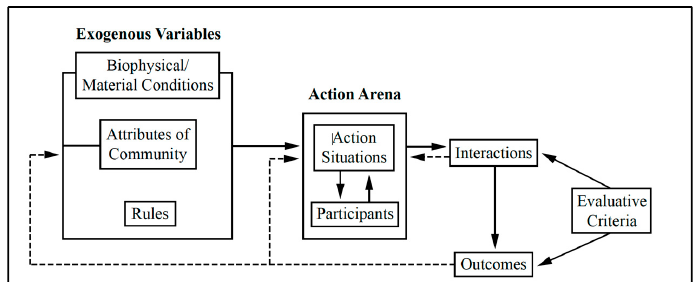
Figure 1. A framework for institutional analysis [26].